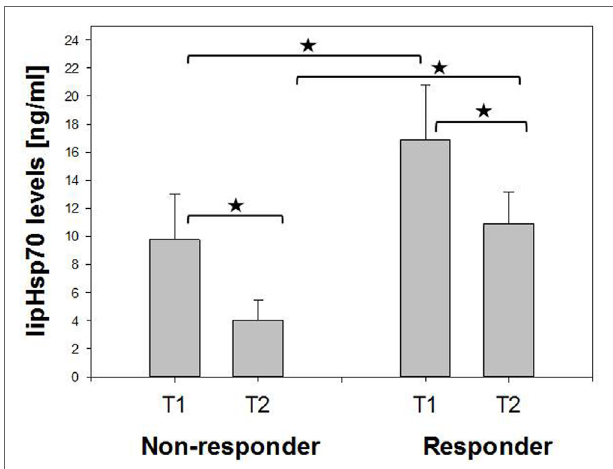
FigUre 2 | Comparison of mean pre- (T1) and post- (T2) therapeutic heat shock protein 70 (Hsp70) plasma levels in non-responding and responding non-small-cell lung cancer patients (M0). Non-responder: 7, responder: 19. Mann–Whitney U test, * p <